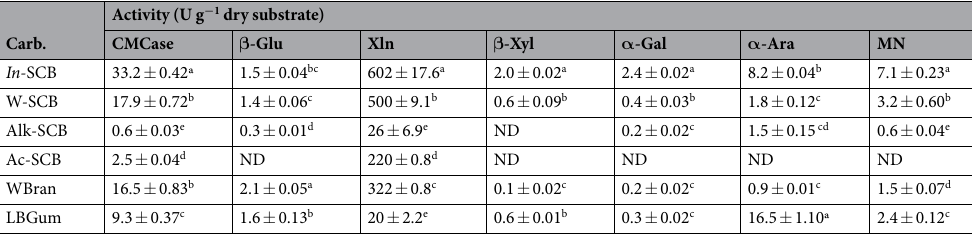
Table 3. Activities produced by Chrysoporthe cubensis under solid state fermentation (SSF) with different carbon sources (Carb.). SCB = sugarcane bagasse; In -SCB = in natura SCB; W-SCB = washed SCB; Alk- SCB = alkali pretreated SCB, Ac-SCB = acid pretreated SCB; WBran = wheat bran; LBGum = locust bean gum. CMCase = carboxymethylcellulase; β -Glu = β -glicosidase; Xyl = xylanase; β -Xyl = β -xylosidase; α -Ara = α -arabinofuranosidase; α -Gal = α -galactosidase; MN = Mannanase; ND = not detected. Averages followed by the same letter do not differ by the Tukey test at 5% of